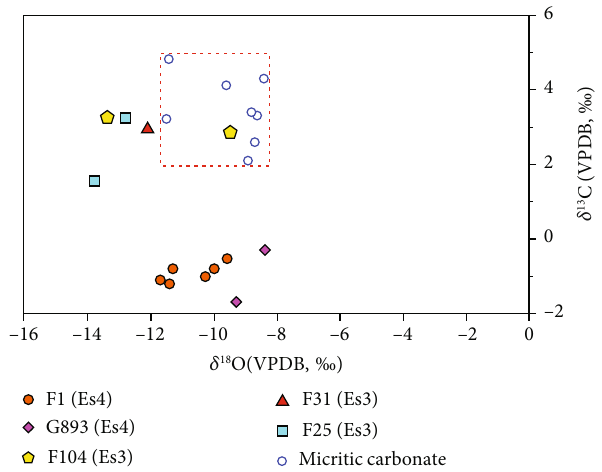
Figure 18: Carbon and oxygen isotopic compositions of carbonate cements and micritic carbonate (red box) within mudstone from Bai et al. [14].